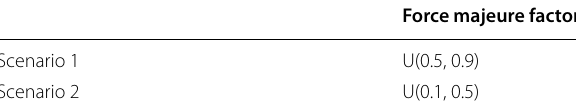
Table 1 Scenarios of the force majeure